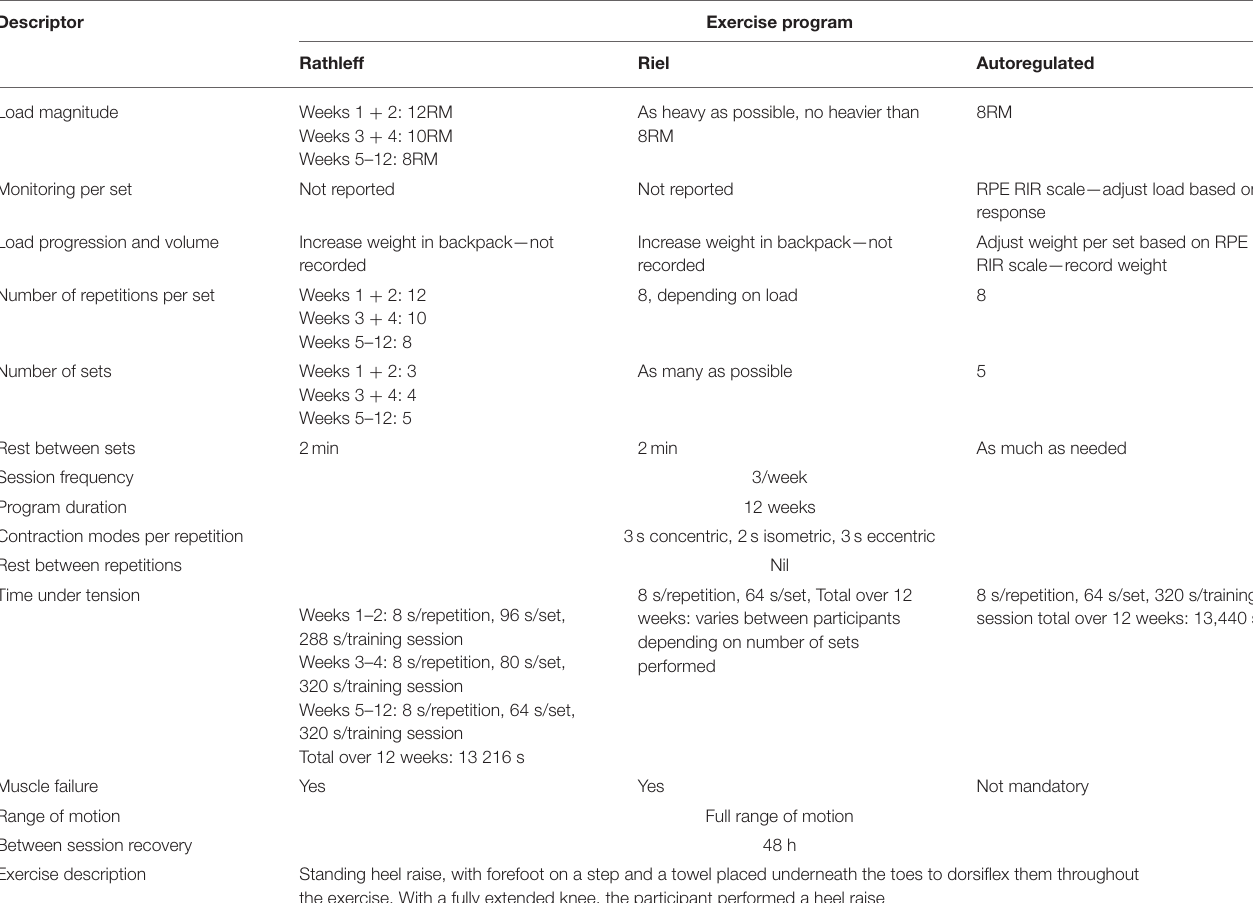
TABLE 5 | Descriptors of Rathleff, Riel and autoregulated